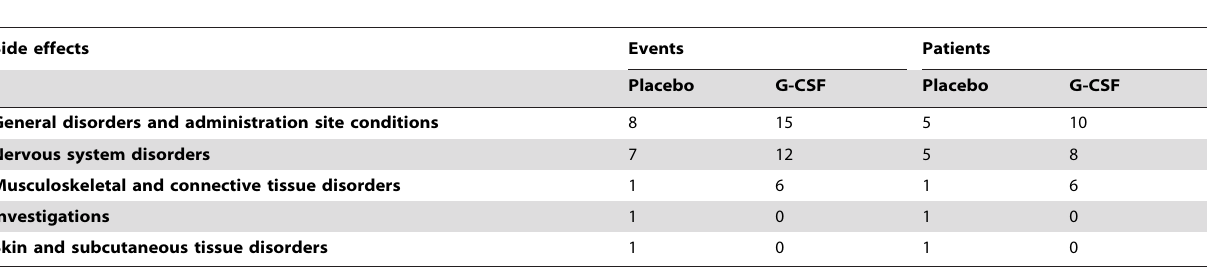
Table 3. All treatment-related adverse events (probable or possible), listed by system organ class (n= 21 in the G-CSF, n =20 in the placebo